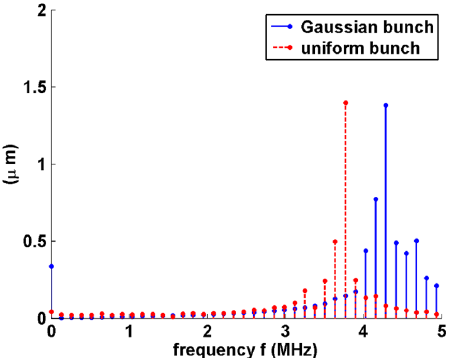
FIG. 5. Fourier analysis of the oscillation of a H þ 2 ion cloud around the beam potential of a 100 MeV bunch.